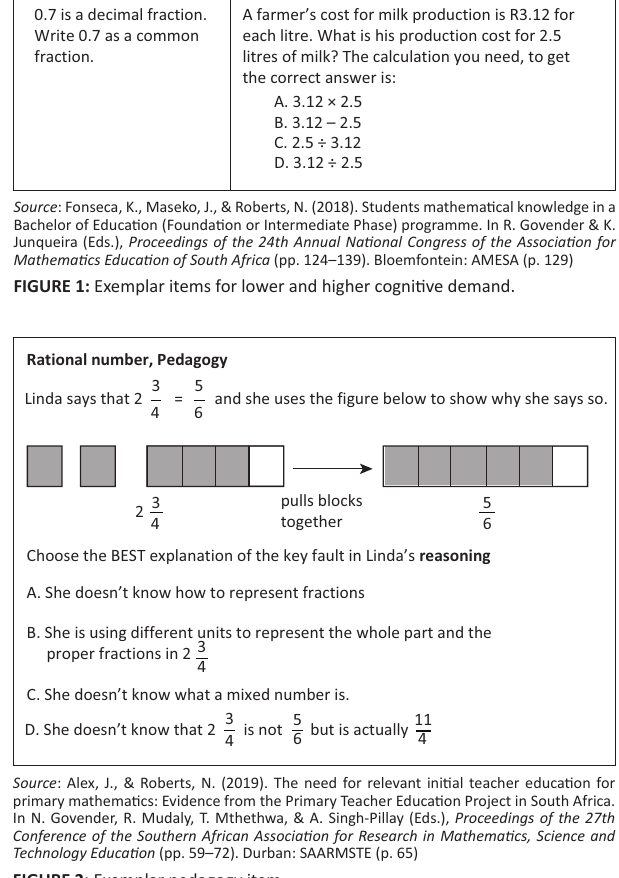
FIGURE 2: Exemplar pedagogy